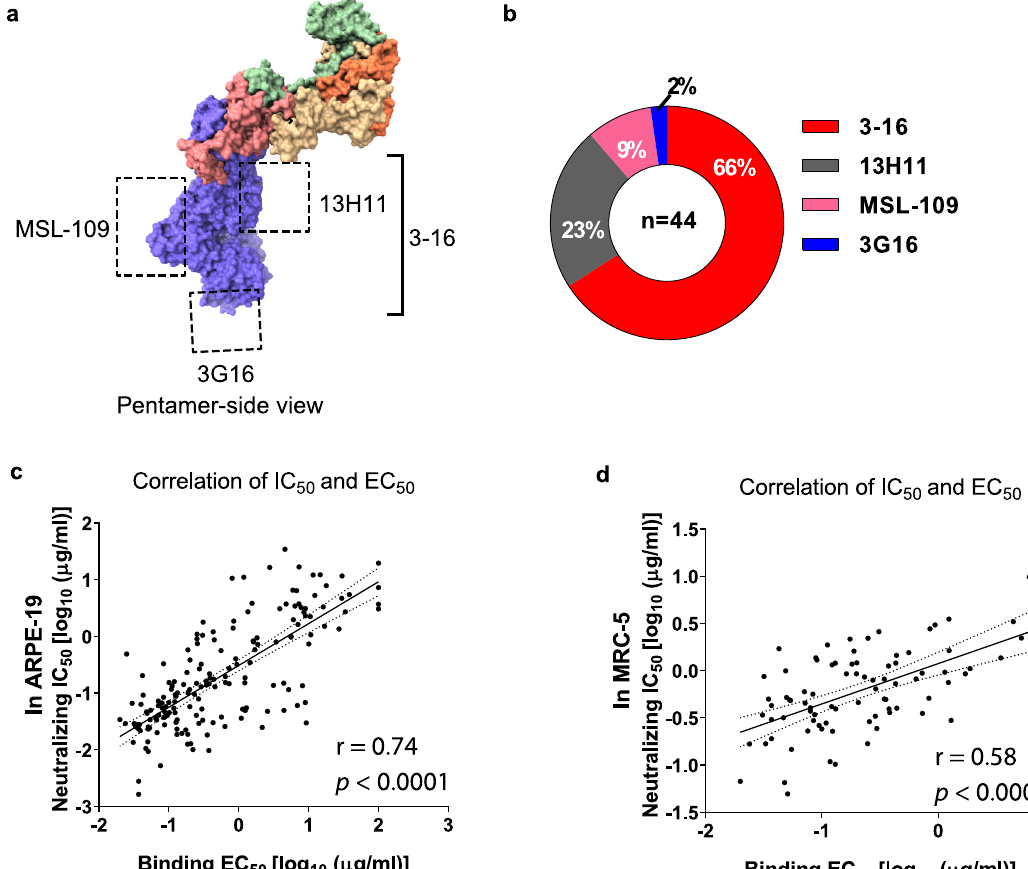
Fig. 5 The gHgL mAbs bind to diverse epitopes on the gHgL. a The binding sites of four gHgL reference antibodies: 3 – 16 binds to the gH of pentamer, 13H11 binds to gHgL kinked region, 3G16 binds to the C-terminal domain of gH, MSL-109 binds to the H2 domain of gH as indicated. b Forty-four gHgL mAbs bind to overlapping regions with the four reference mAbs: 66% to the 3 – 16 epitope, 23% to the 13H11 epitope, 9% to MSL-109 epitope, and 2% to the 3G6 epitope. c , d Neutralization potency (IC 50 ) of the gHgL mAbs in ARPE-19 cells ( c ), and MRC-5 cells ( d ), positively correlates with their binding af fi nity (EC 50 ) to the HCMV virion. The IC 50 and EC 50 values shown are representative of two independent experiments. The linear association was calculated by the Pearson correlation, two-tailed. The Molecular graphic images of pentamer (PDB: 5VOD) were produced using UCSF ChimeraX